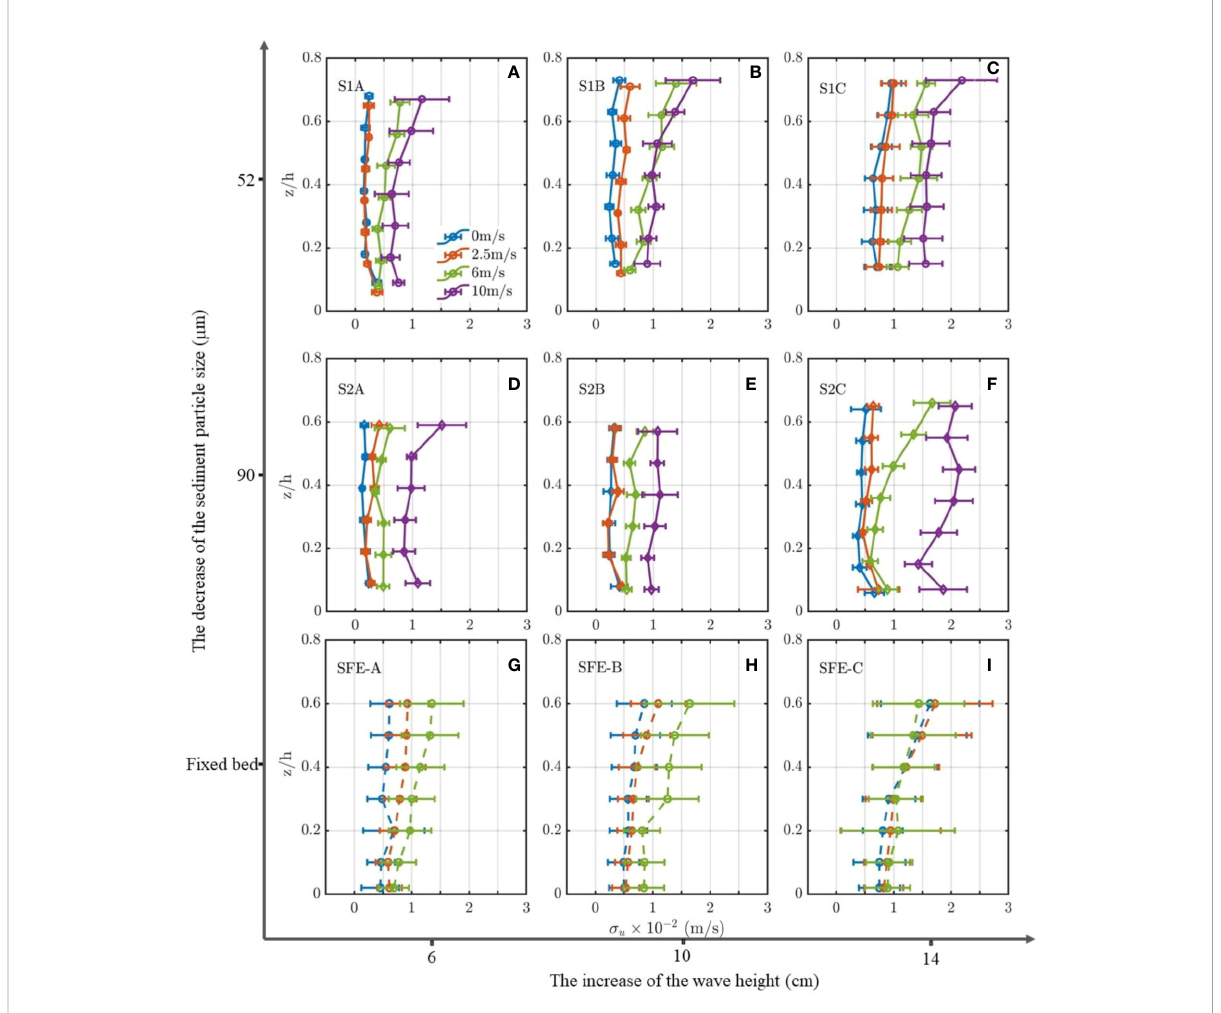
FIGURE 5 Time-averaged s u of S1 (A – C) , S2 (D – E) and 2017-SFE (G – I) . Lines of different colors represent waves combined with the wind of various strengths. The capital letters in the upper left of each graph represent the sediment type and the experimental case. Bars are ensemble standard